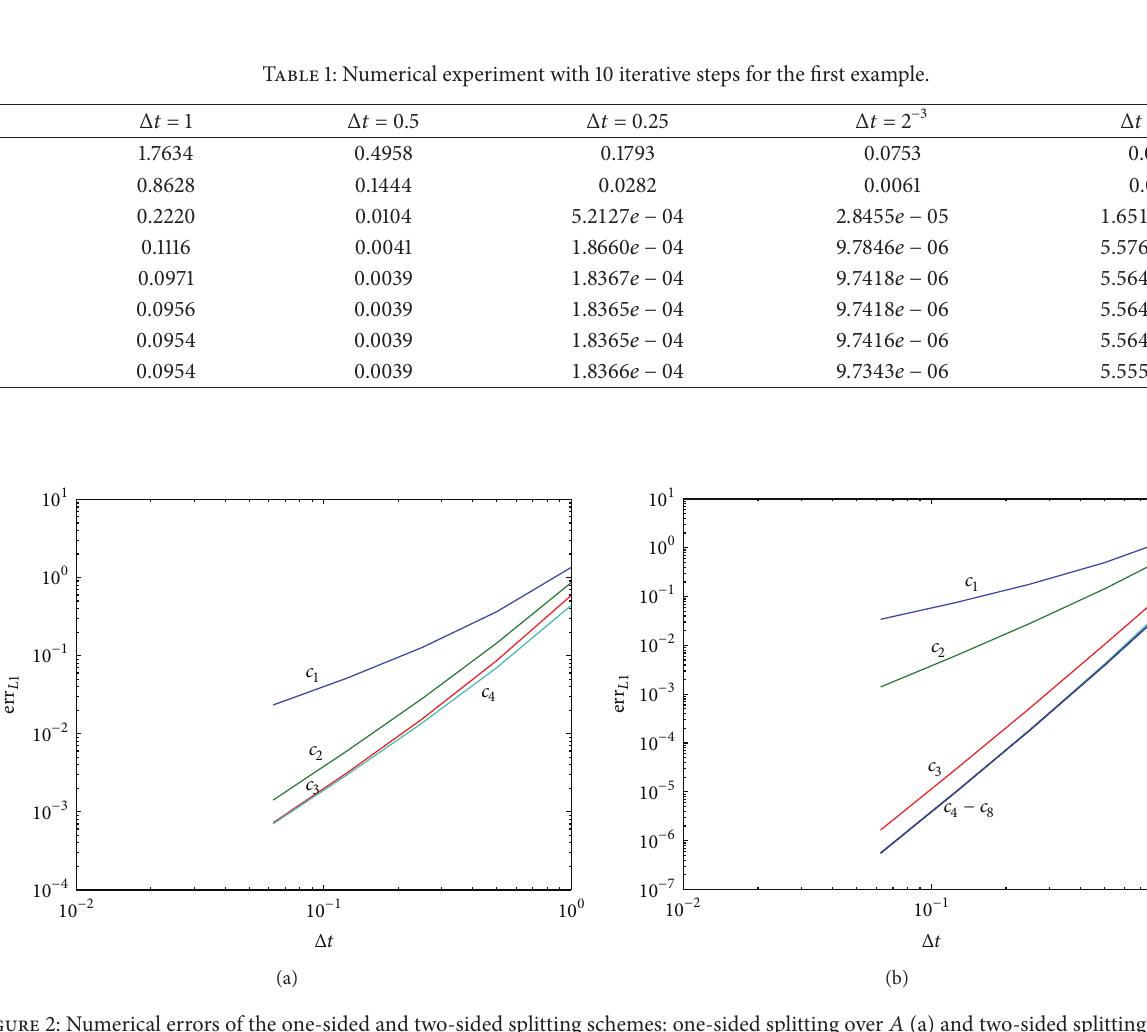
Figure 2: Numerical errors of the one-sided and two-sided splitting schemes: one-sided splitting over 𝐴 (a) and two-sided splitting scheme alternating between 𝐴 and 𝐵 (b) with 1, ...,8 iterative